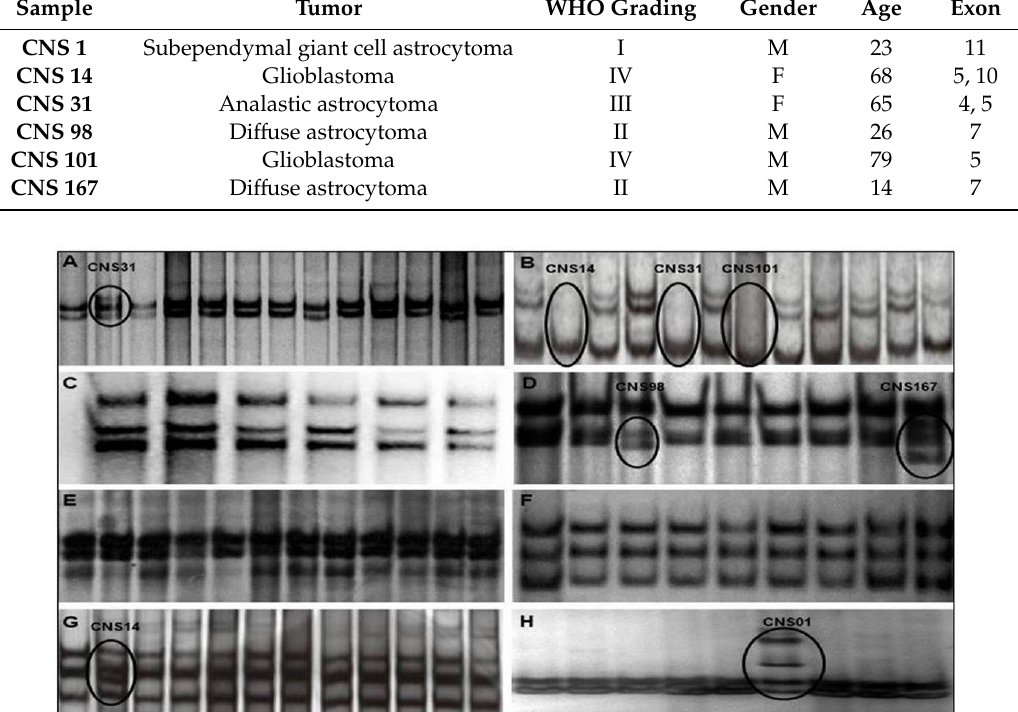
Table 2. TP53 mutated gliomas.